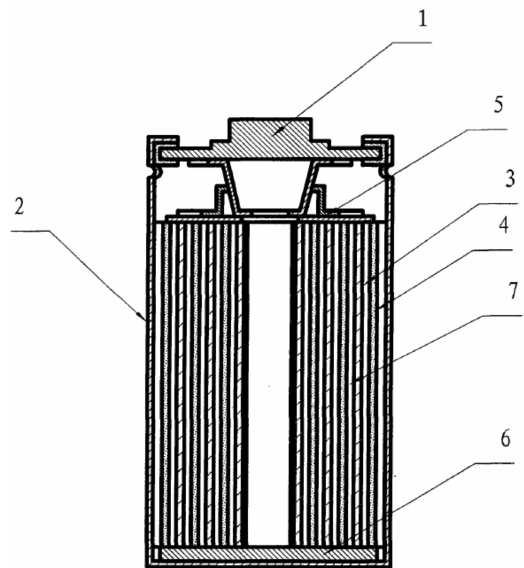
Figure 19. Schematic diagram of a high-power cell with 1: vent cap, 2: can, 3: positive electrode coated with co-precipitated hydroxide of Co, Y, and Ce, 4: negative electrode coated with carbon nanotube, 5: negative current collector, 6: positive current collector, and 7: separator [244].